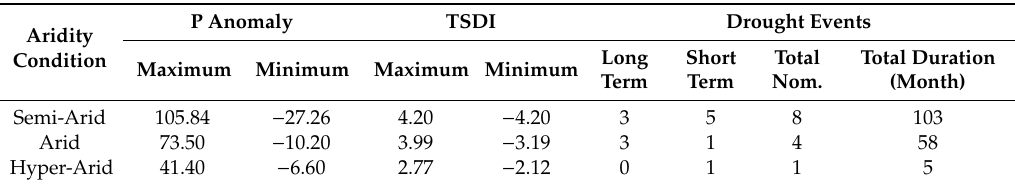
Table 9. Comparison of the range of precipitation anomalies, TSDI, frequency, and total drought durations in each climatic zone (2002 to